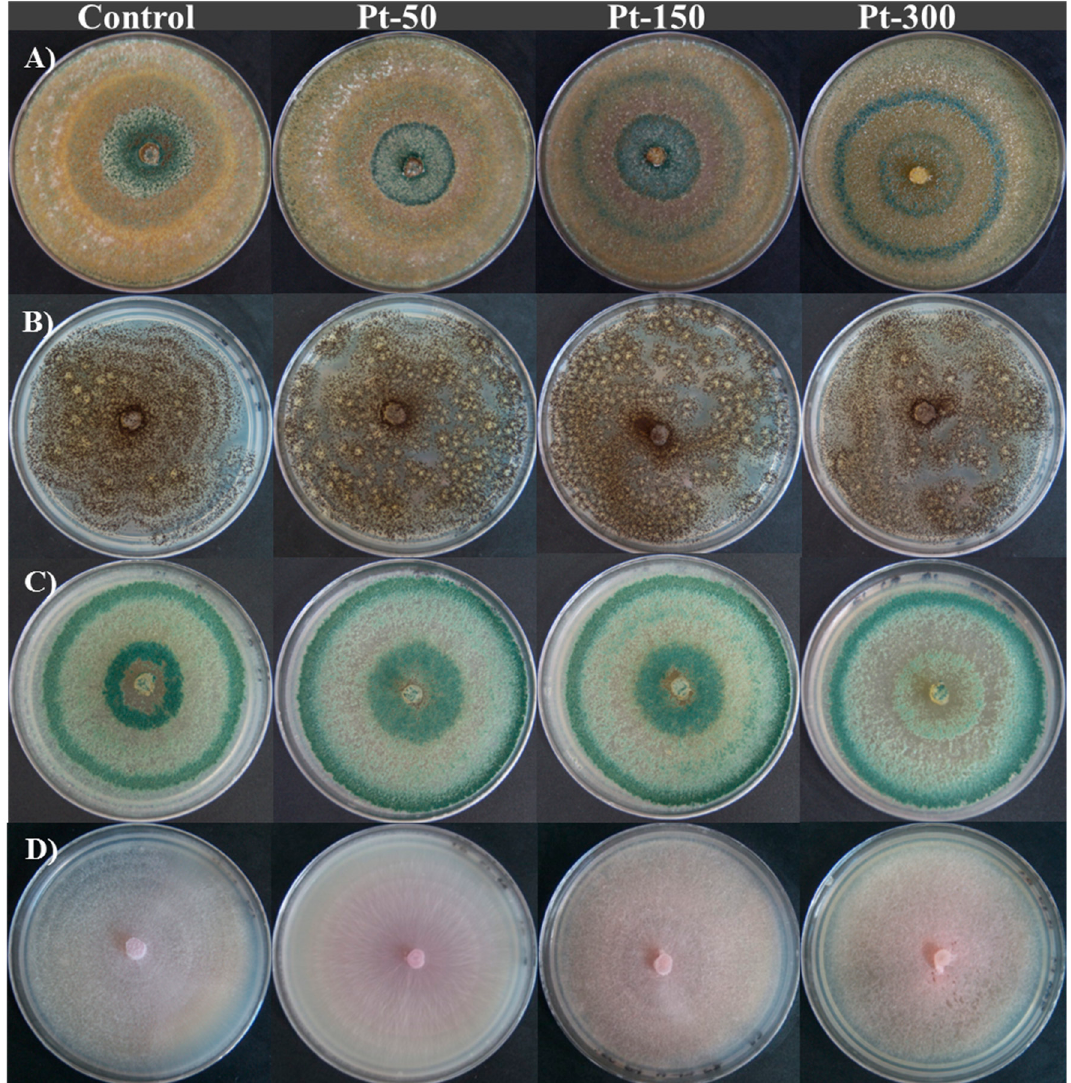
Figure 9. Morphological characteristics of four filamentous fungi exposed to four doses of platinum for 20 days. ( A ) Trichoderma harzianum MX2, ( B ) Aspergillus niger MX5, ( C ) Hypocrea lixii MXPE12 and ( D ) Fusarium oxysporum MX17.